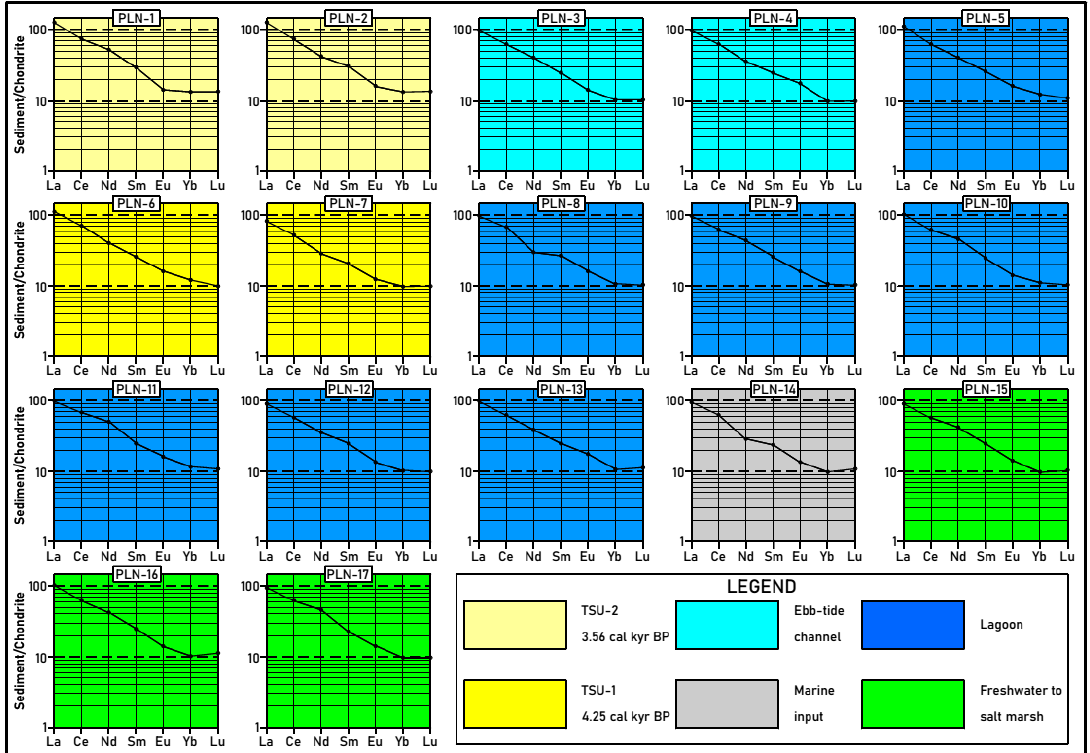
Figure 10. EE abundances normalized to the chondrite values in core PLN. The Y-axis is in a logarithmic scale .